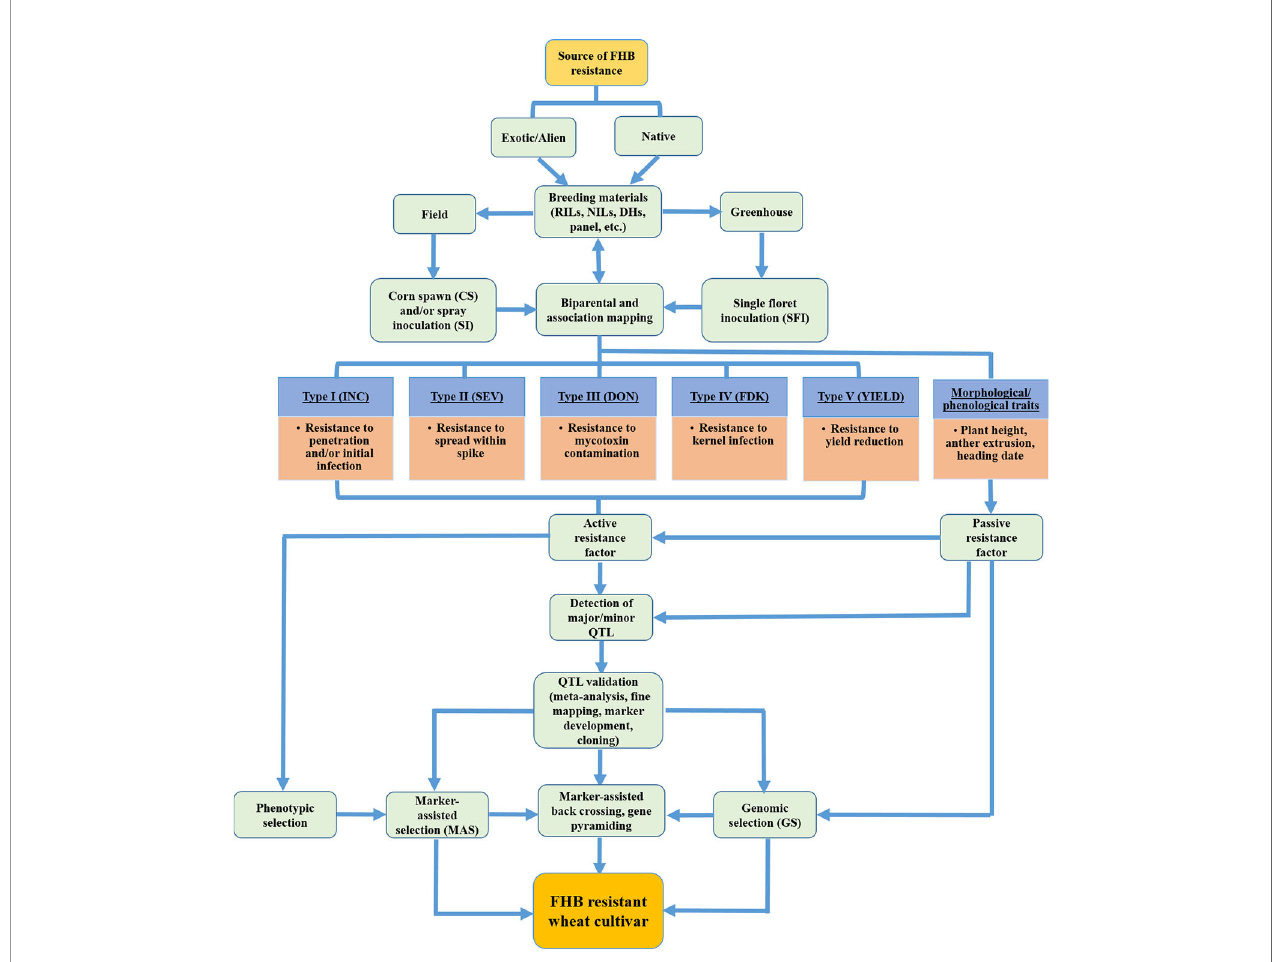
FIGURE 3 | Schematic fl ow diagram showing overall breeding effort for assessing FHB resistance types, QTL detection and validation, and development of FHB resistant wheat cultivars. (Source: Figure 3 , B.